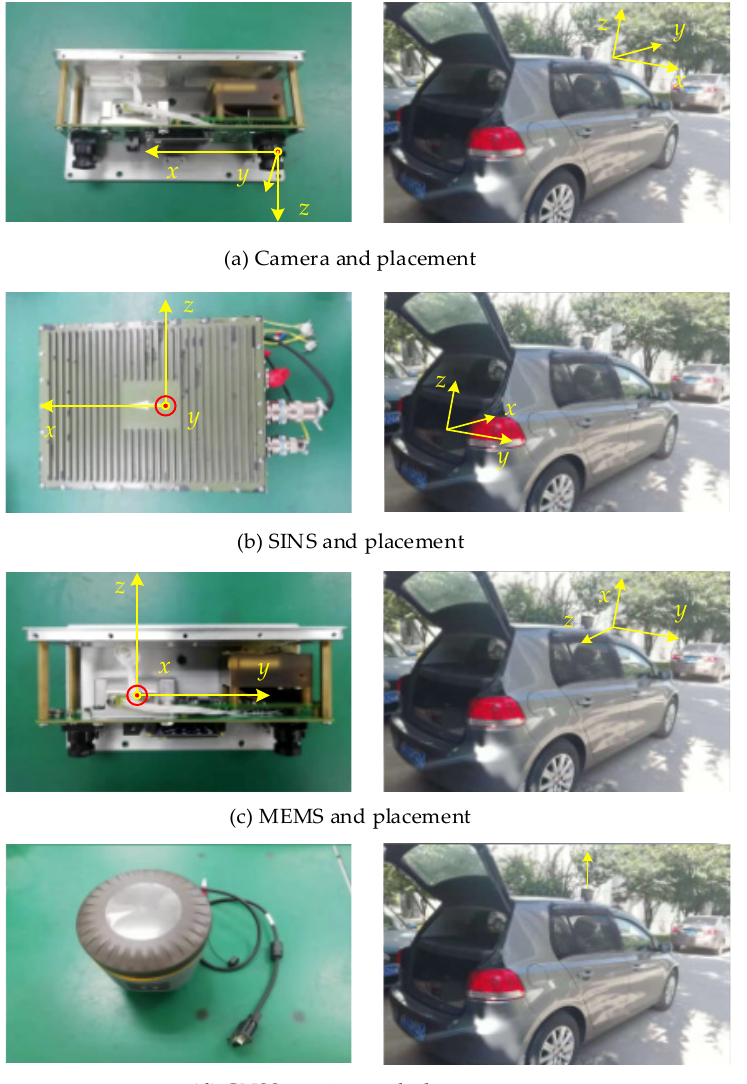
Figure 3. The platform of road test experiments. ( a ) The coordinate of the camera and the placement in the road test vehicle. ( b ) The coordinate of the SINS and the placement in the road test vehicle. ( c ) The coordinate of the MEMS and the placement in the road test vehicle. ( d ) The placement of the GNSS in the road test vehicle.